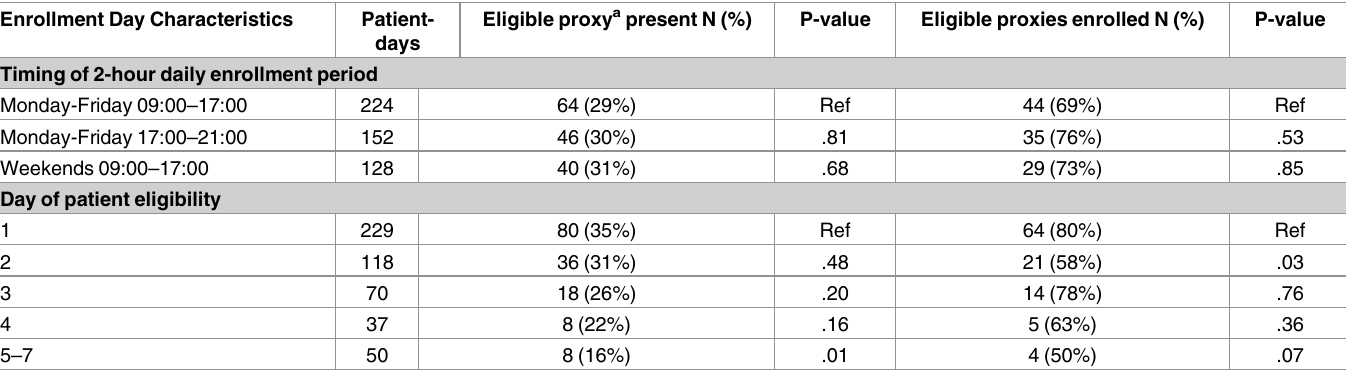
Table 2. Proxy availability and